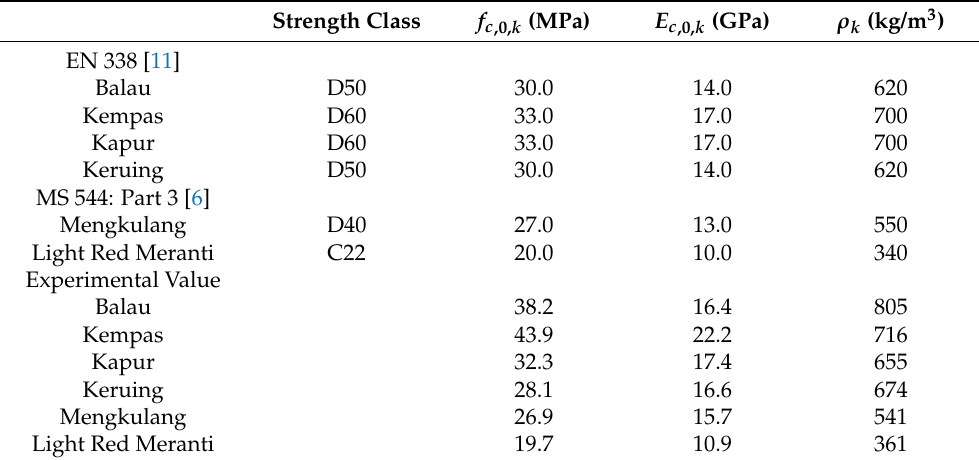
Table 4. Comparison of strength classes specified in EN 338, MS 544: Part 3 with experimental characteristic